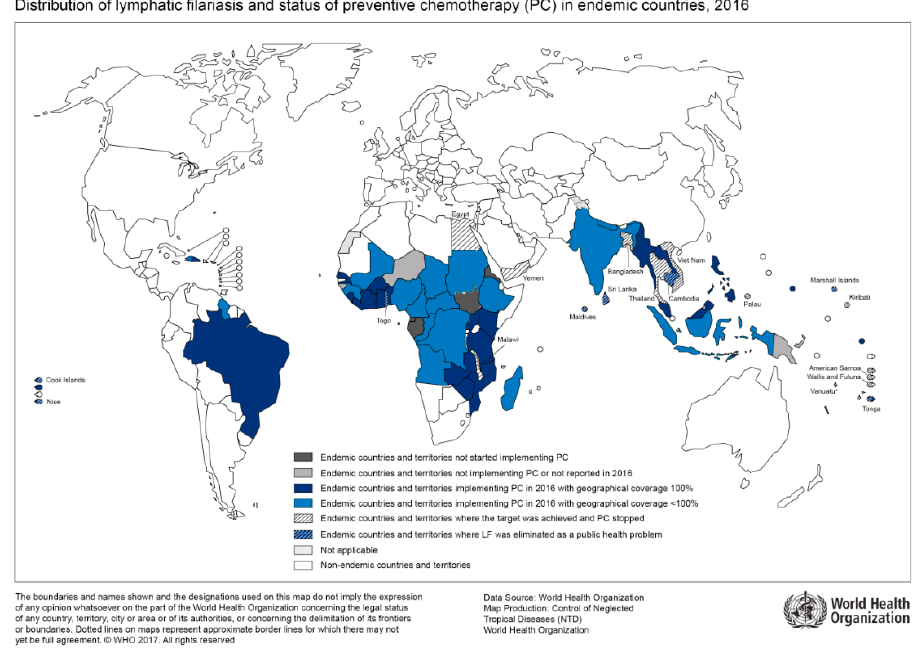
Figure 2. Countries endemic for lymphatic filariasis and status of mass drug administration, 2016 (Source: WHO, website: http://gamapserver.who.int/mapLibrary/Files/Maps/LF_2016.png).